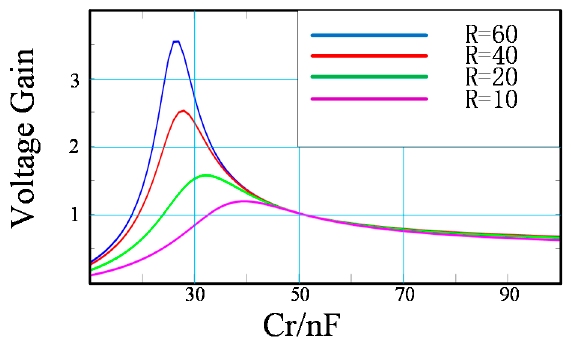
Figure 7. Voltage gain curves of the impedance voltage regulation by the FHA model.